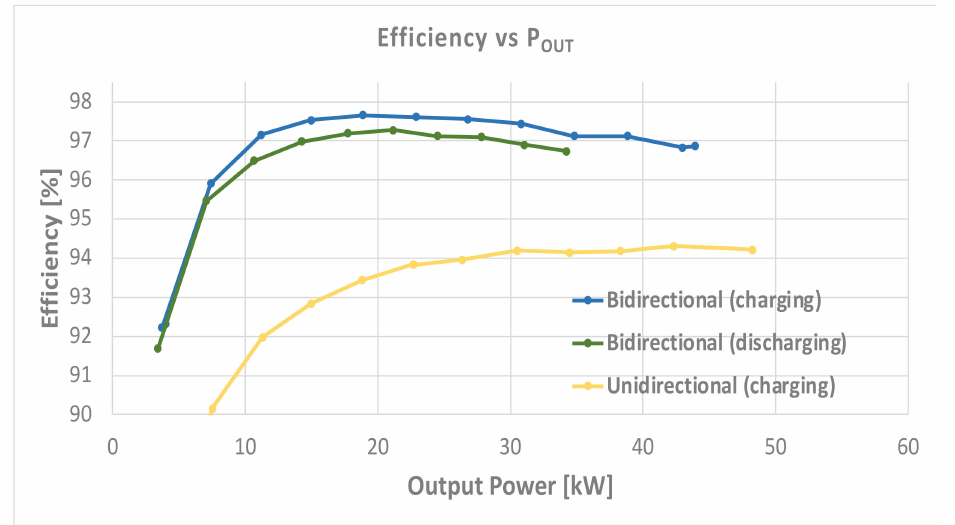
Figure 20. Efficiency characteristics vs. output power (P OUT ) of the analyzed DCFC systems for different operation modes, from the top: efficiency characteristic of bidirectional charger with SiC power transistors during charging mode (dark blue); efficiency characteristic of bidirectional charger with SiC power transistors during discharging mode (dark green); efficiency characteristic of unidirectional charger with IGBT power transistors during charging mode (yellow). Battery voltage range: 360–410